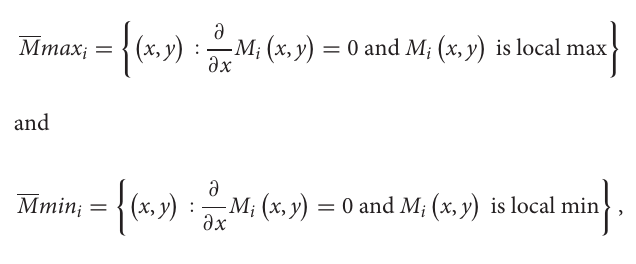
characterizing distribution of convex and concave parts (dark and light